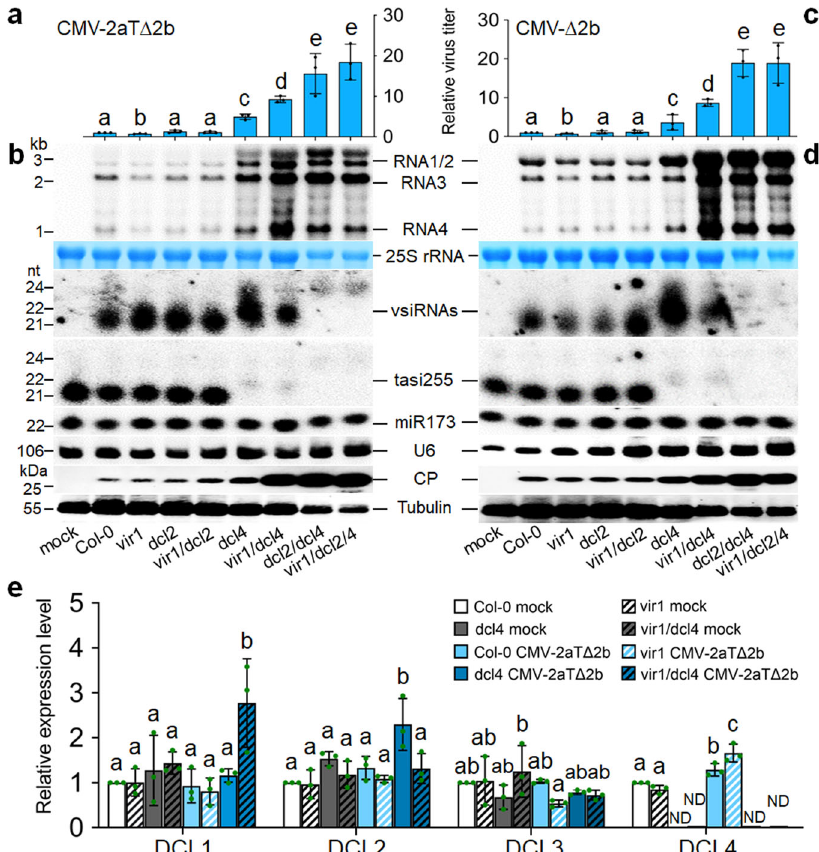
Fig. 4 VIR1 is a negative regulator of antiviral RNAi. a – d Accumulation of CMV-2aT Δ 2b ( a , b ) or CMV- Δ 2b ( c , d ) detected in wild-type (Col-0), single, double or triple mutant plants as indicated at 2 weeks post-infection by RT-qPCR analysis of the viral RNA3 ( a , c ), Northern blotting of the viral RNAs 1 – 4 ( b , d ), or Western blotting of the viral CP ( b , d ). The vsiRNAs and plant endogenous small RNAs were also detected by Northern blotting ( b , d ). Note the reduced sample loading (to ½) for total proteins and total RNAs from dcl2 / 4 double mutant plants and vir1 / dcl2 / 4 triple mutant plants ( b , d ). e RT-qPCR analysis of DCL1 , DCL2 , DCL3 and DCL4 mRNA levels in wild-type (Col-0), single or double mutant plants without infection or one week post-infection with CMV-2aT Δ 2b as indicated. A. thaliana EF1 α ( At5g60390 ) mRNA was used as internal control. Data in ( a ), ( c ) and ( e ) are means ± SEM from three independent experiments, letters indicate groups with signi fi cant differences (one-way ANOVA, Duncan, p < 0.05) and green dots represent the individual values. ND not determined. The source data underlying blots in ( b ) and ( d ), and qRT-PCR data in ( a ), ( c ) and ( e ) are provided as a Source Data fi